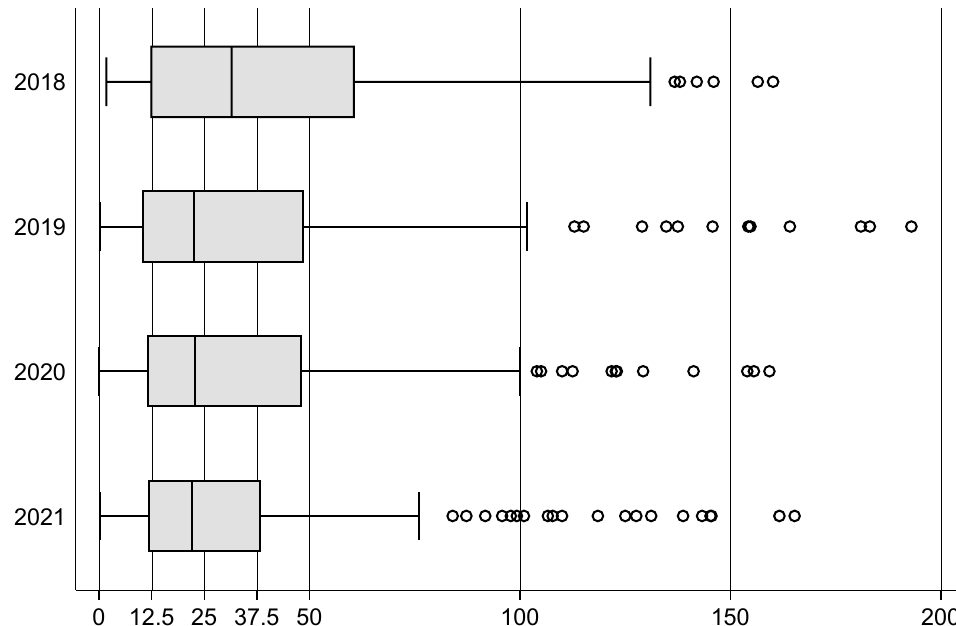
Figure 3. Boxplot of restraint duration in hours per total number of restraints . Legend: vertical bar in box denotes median, and edges of rectangles the 25th and 75th percentiles, whiskers extend to include all data points within 1.5 times the interquartile range, circles denote outside values. Note: Fourteen outliers between 200 h and 807 h were omitted for better scalability.